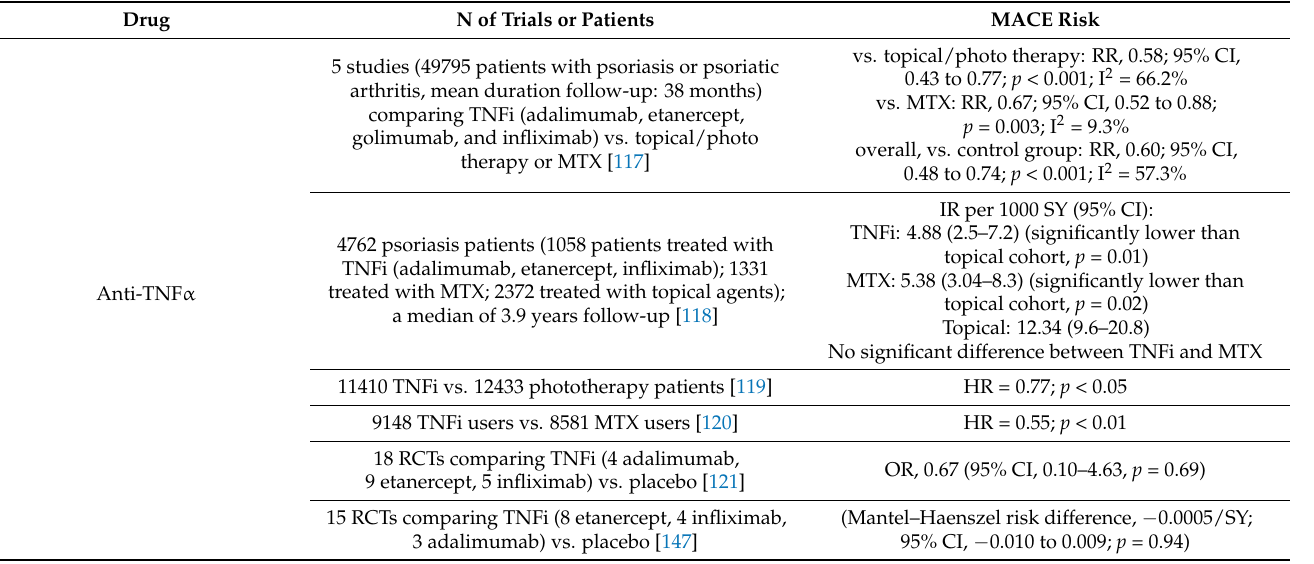
Table 1. Summary of the main studies on the rates of MACEs in psoriatic patients treated with biological